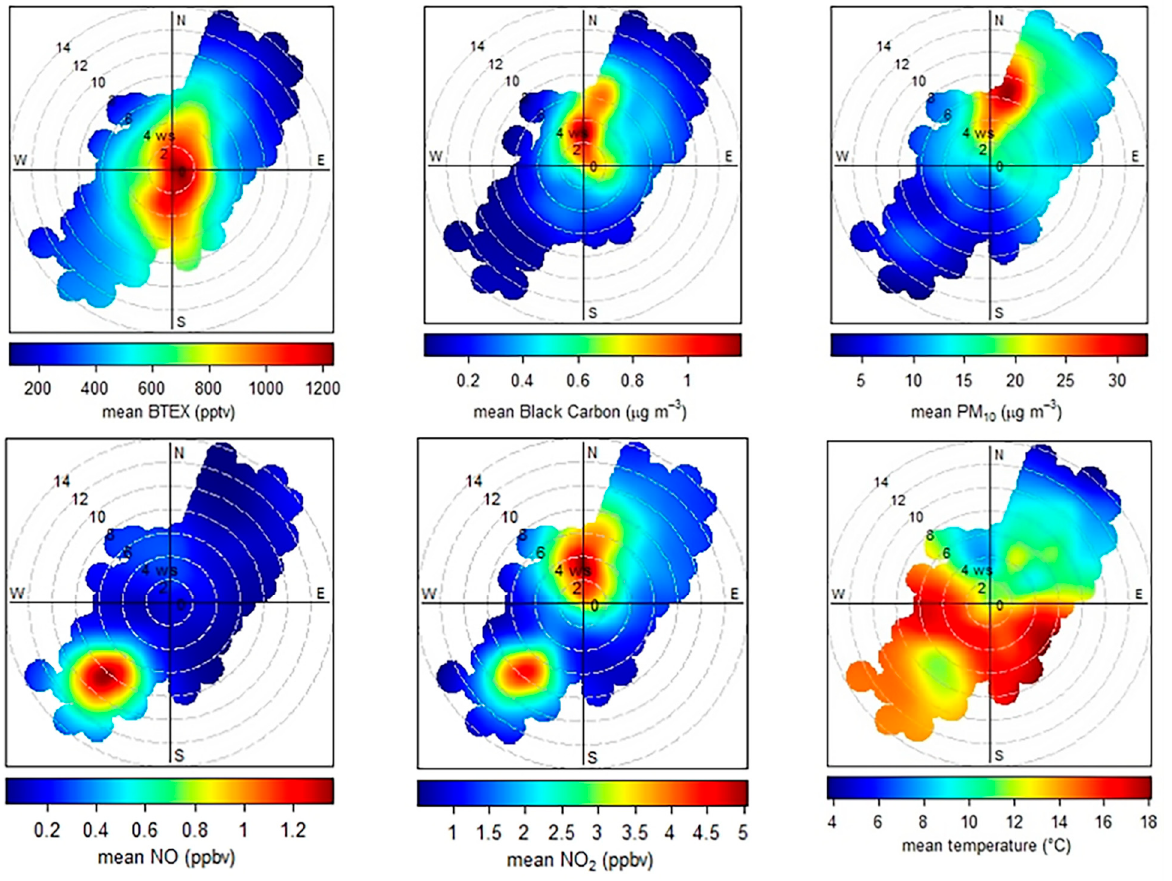
Figure 8. Polar plots of BTEX, NO, NO 2 , O 3 , PM 10 , BC, and temperature (T) for lockdown (from 17 Mar to 10 May); ws = wind speed (m s –1